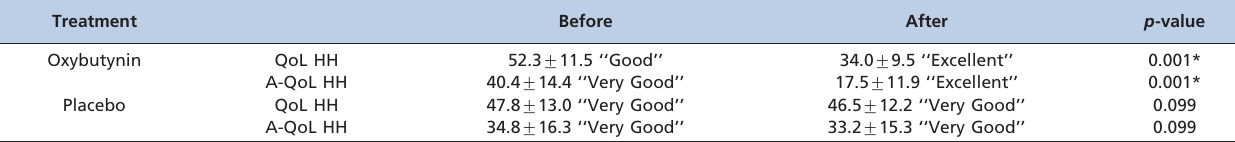
Table 3 - Oxybutynin and placebo groups - Means and standard deviations of the questionnaire results (measured and corrected) before and after the intervention.